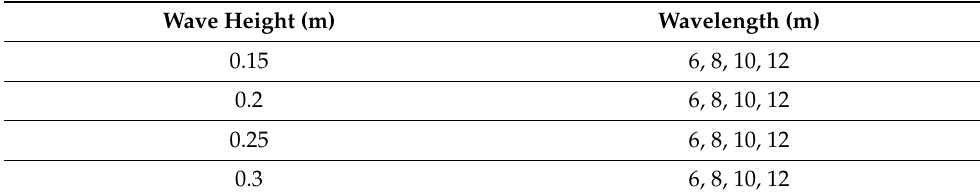
Table 7. Wave parameters.